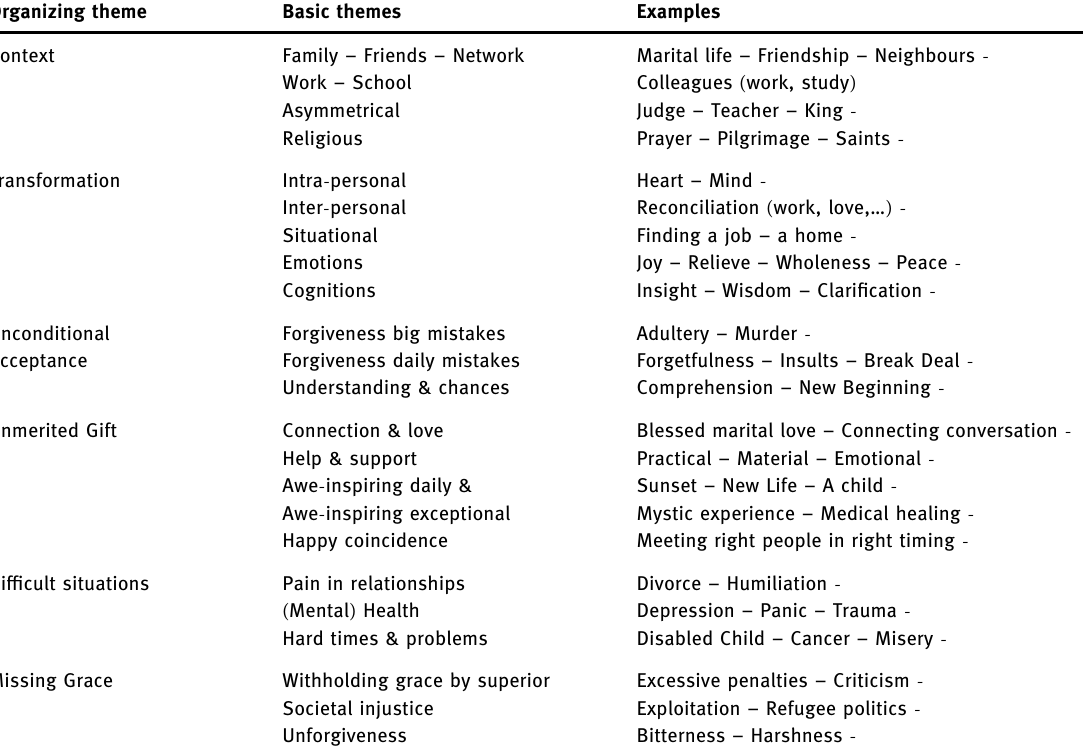
Table 2: Experiencing grace: organizing and basic themes with examples of the narratives Organizing